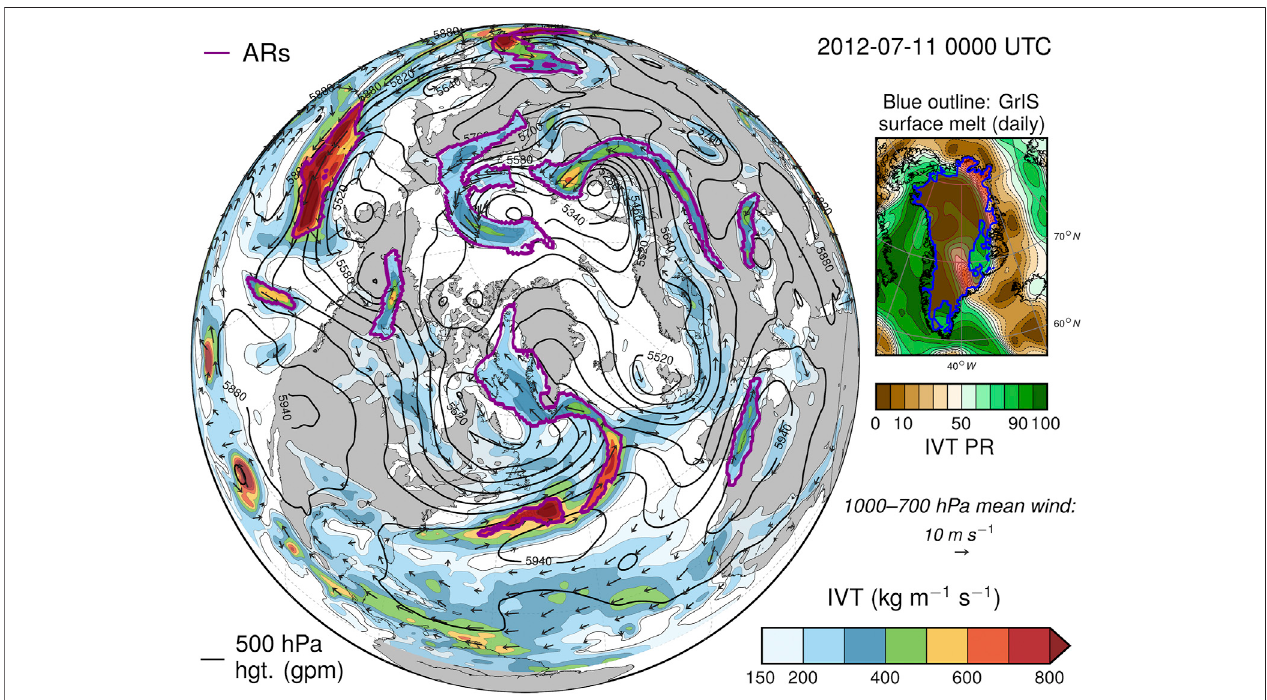
FIGURE 1 | Example of atmospheric rivers detected using MERRA-2 data at July 11, 2012 0000 UTC. Purple outlines identify features classi fi ed as atmospheric rivers based on the criteria outlined in Mattingly et al. (2018); Table 1.